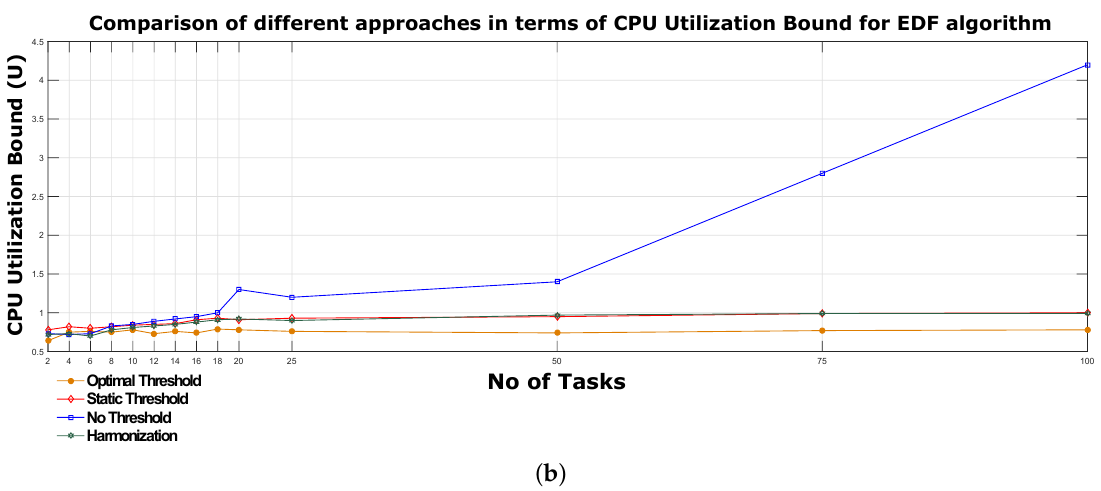
Figure 10. Effect of CPU Utilization Bound on varying input task load for RM and EDF algorithms, given Period = 1–10, Execution Time Range = 1–5, Arrival Time Range = 1–5. ( a ) effect of CPU Utilization Bound on RM algorithm—Existing Approaches vs. Proposed Approach; ( b ) effect of CPU Utilization Bound on EDF algorithm—Existing Approaches vs. Proposed